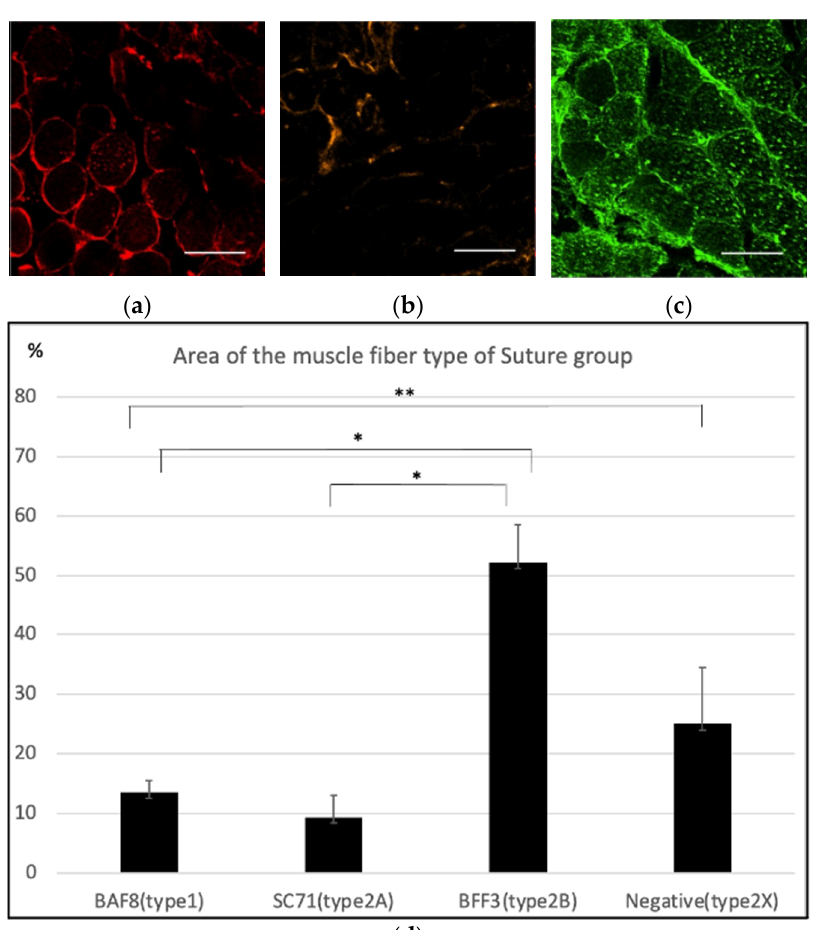
Figure 4. Immunohistochemistry of the masseter muscle in the suture group. ( a ) Anti-BAF8 (red) staining was slightly positive in some areas. ( b ) Anti-SC71 (orange) staining was performed to detect type 2A fibers, and a slightly positive area was observed. ( c ) Anti-BFF3 (green) staining suggested that most of the masseter muscle fibers in the suture group were composed of type 2B fibers. Nuclear counterstaining was performed using DAPI (blue). Scale bar = 100 µ m. ( d ) Anti-BAF8-, anti-SC71-, and anti-BFF3-positive areas and the negative area for all antibodies were analyzed with four specimens. The average percentage area of type 1, type 2A, type 2B and the estimated type 2X fibers were 13.50 ± 2.83%, 9.38 ± 2.01%, 52.17 ± 8.30% and 25.00 ± 7.72%, respectively. ( n = 4 for each group, * p < 0.01, ** p < 0.05, one-way ANOVA). In the cut group, most specimens featured an area that was negative for BAF8, SC71 and BFF3 (Figure 5a–c). The average percentages of type 1, type 2A, type 2B and the estimated type 2X muscle fibers were 0.92 ± 0.87%, 6.67 ± 6.65%, 27.99% ± 10.80%, and 64.42 ± 7.68%, respectively (Figure 5d).